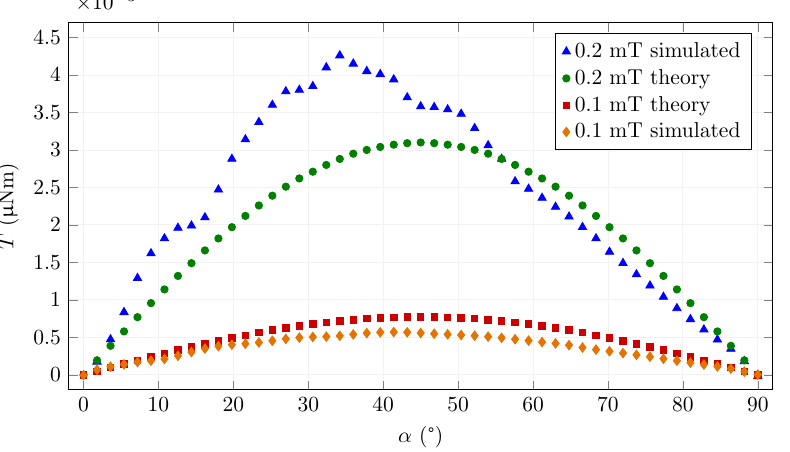
Figure 5. An example of the dependence of the mechanical torque acting on a Weidacon FM fibre on the angle of rotation when the magnetic induction in the air around the fibre is B 0 = 0.1 mT and B 0 = 0.2